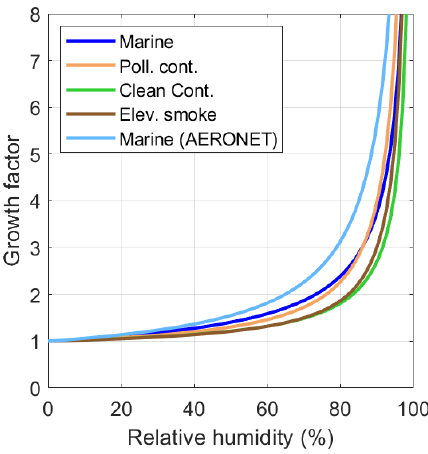
Figure 1. Hygroscopic growth factor for different values of rel- ative humidity for different aerosol types estimated from the mi- crophysical properties of CALIPSO aerosol models, with marine (blue), polluted continental (orange), clean continental (green), and elevated smoke (brown). The growth factor estimated using a new AERONET-based marine model (sky blue) from Sayer et al. (2012) is also shown. The hygroscopic growth factor at a certain relative humidity is defined as the ambient-to-dry extinction coefficient ra- tio.